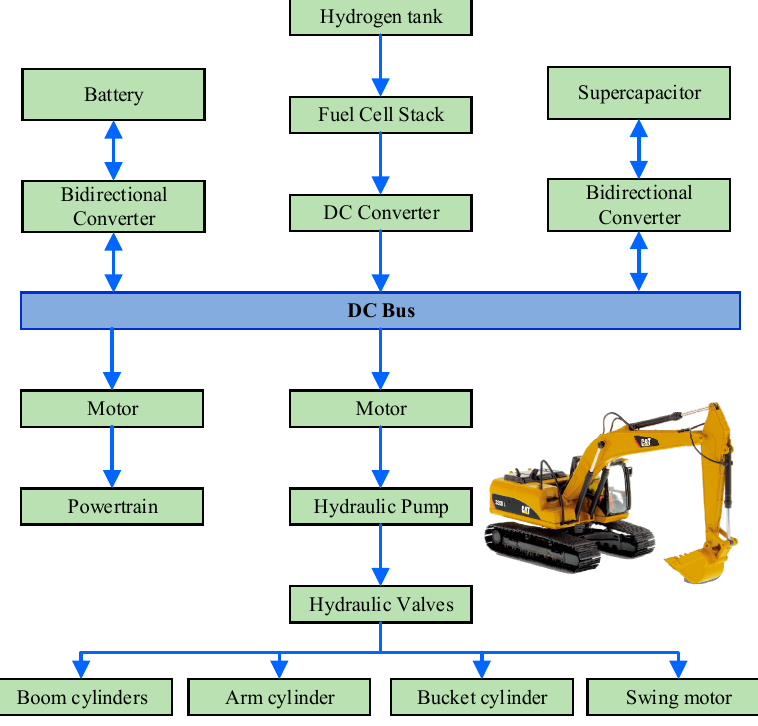
Figure 2. Energy flow of the proposed PEMFC-HE.